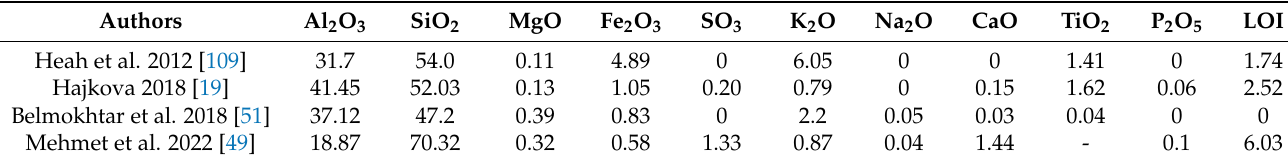
Table 7. Chemical composition of kaolin